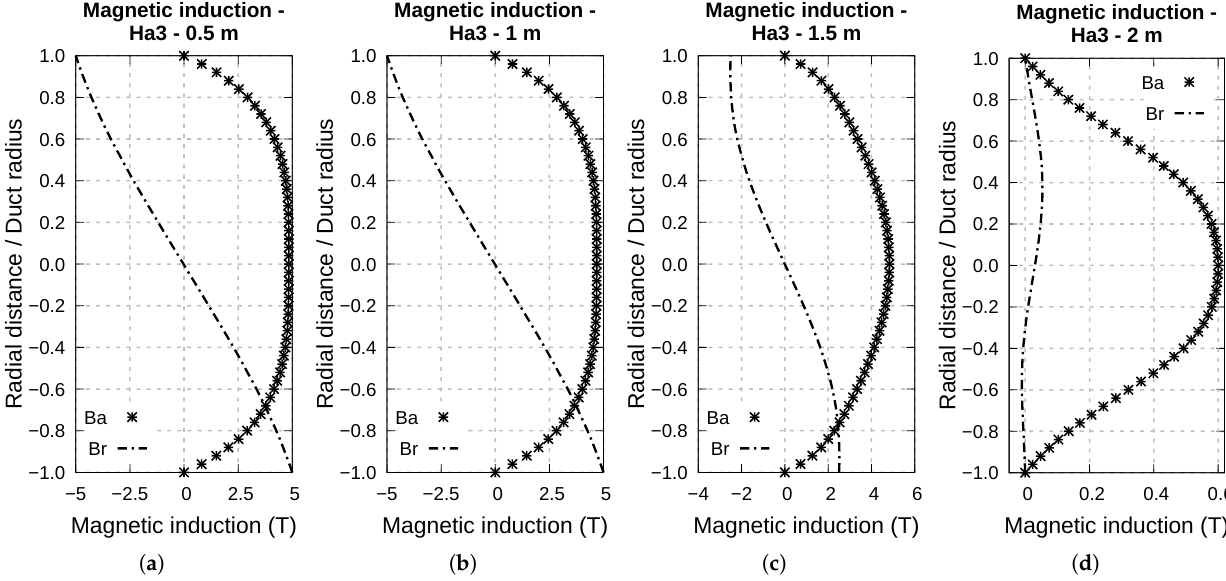
Figure 12. Behavior of axial and radial components of magnetic induction at the positions ( a ) 0.5 m, ( b ) 1.0 m, ( c ) 1.5 m and ( d ) 2.0 m from the duct inlet. Hartmann number is Ha 3 and magnets are in the repulsive